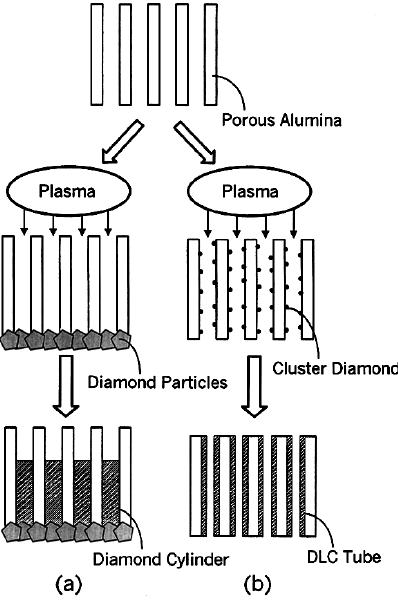
Figure 22. Schematic diagram showing the route for the fabrication of diamond nanostructures within PAA templates proposed by Masuda et al. [213]. (a) Diamond NPs with the same pore size deposited at bottom of the pores to synthesize diamond nanocylinders, and (b) smaller NPs than the pore size dispersed in an ultrasonic bath to nucleate diamond-like carbon (DLC) nanotubes. Reprinted with permission from Ref. [213]. Copyright © 2023 WILEY-VCH Verlag GmbH & Co. KGaA, Weinheim.